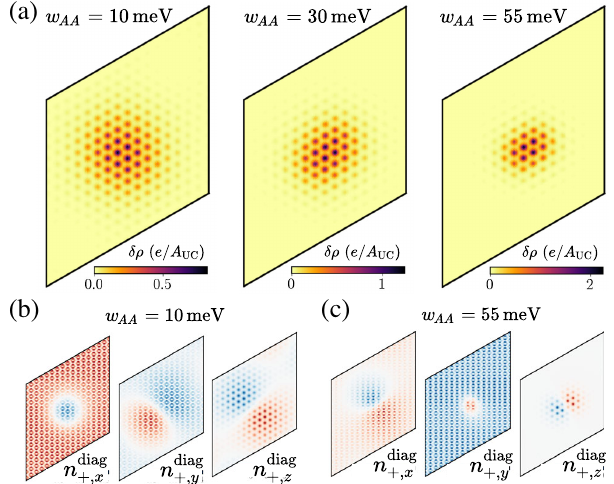
FIG. 5. Paired 2 e skyrmions (spinless ν ¼ 0 ). (a) Charge density δρ ð r Þ of paired skyrmions for different w AA . (b),(c) Local pseudospin orientation in one Chern sector corresponding to the first and third panels of (a). Note the increasing degree of anisotropy and confinement for increasing chiral ratio. System size is 16 × 16 with the average